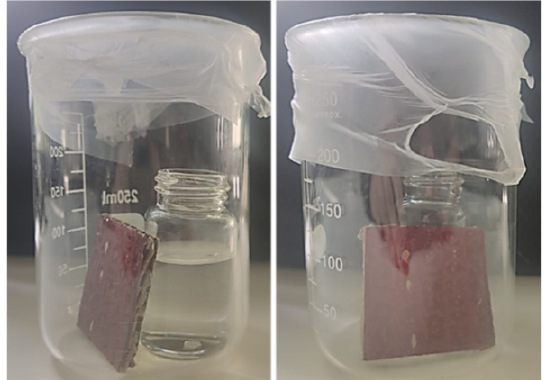
Figure 2. Developed set-up to evaluate the gas sensitivity of the